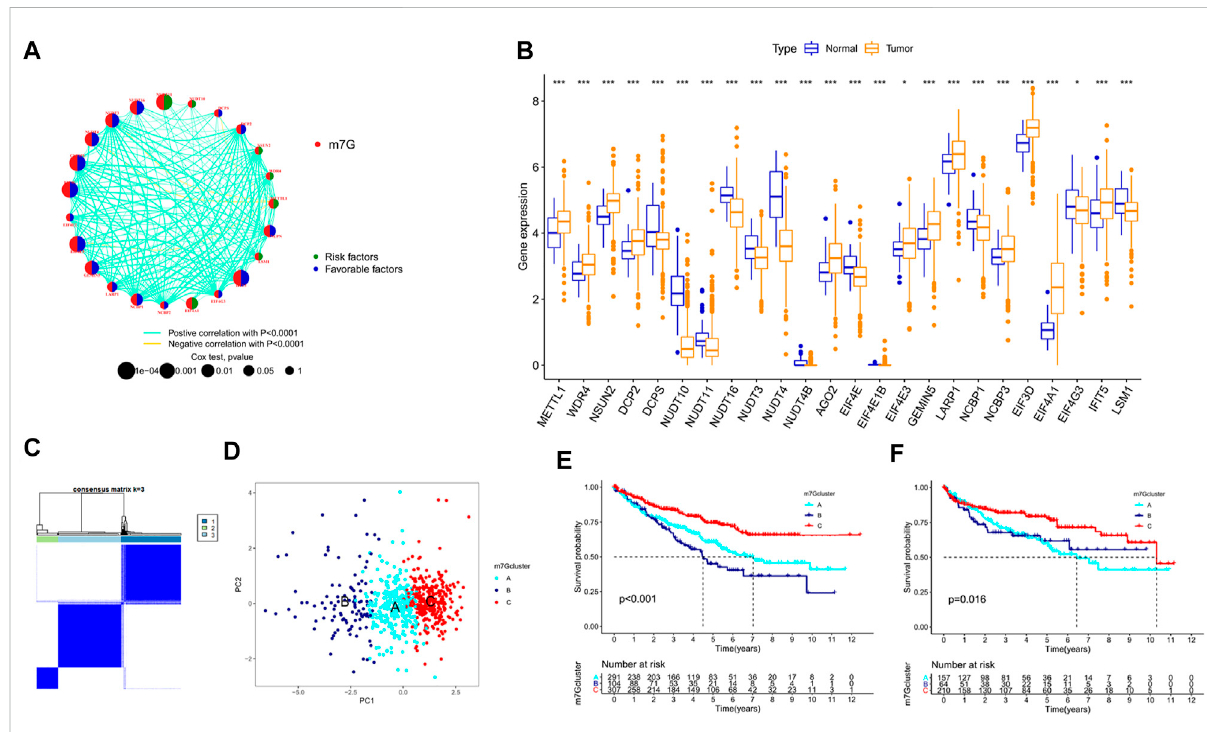
FIGURE 1 Unsupervised clustering analysis of m7G regulators in KIRC. (A) Interaction network of m7G regulators. (B) Expression levels of m7G regulators in KIRC. (C) Heat maps of the consensus clustering matrix. (D) PCA distinguishing the three subtypes. (E – F) K – M curves of OS and DFS in the three subtypes. KIRC, kidney renal clear cell carcinoma; OS, overall survival; DFS, disease-free survival; K – M, Kaplan –